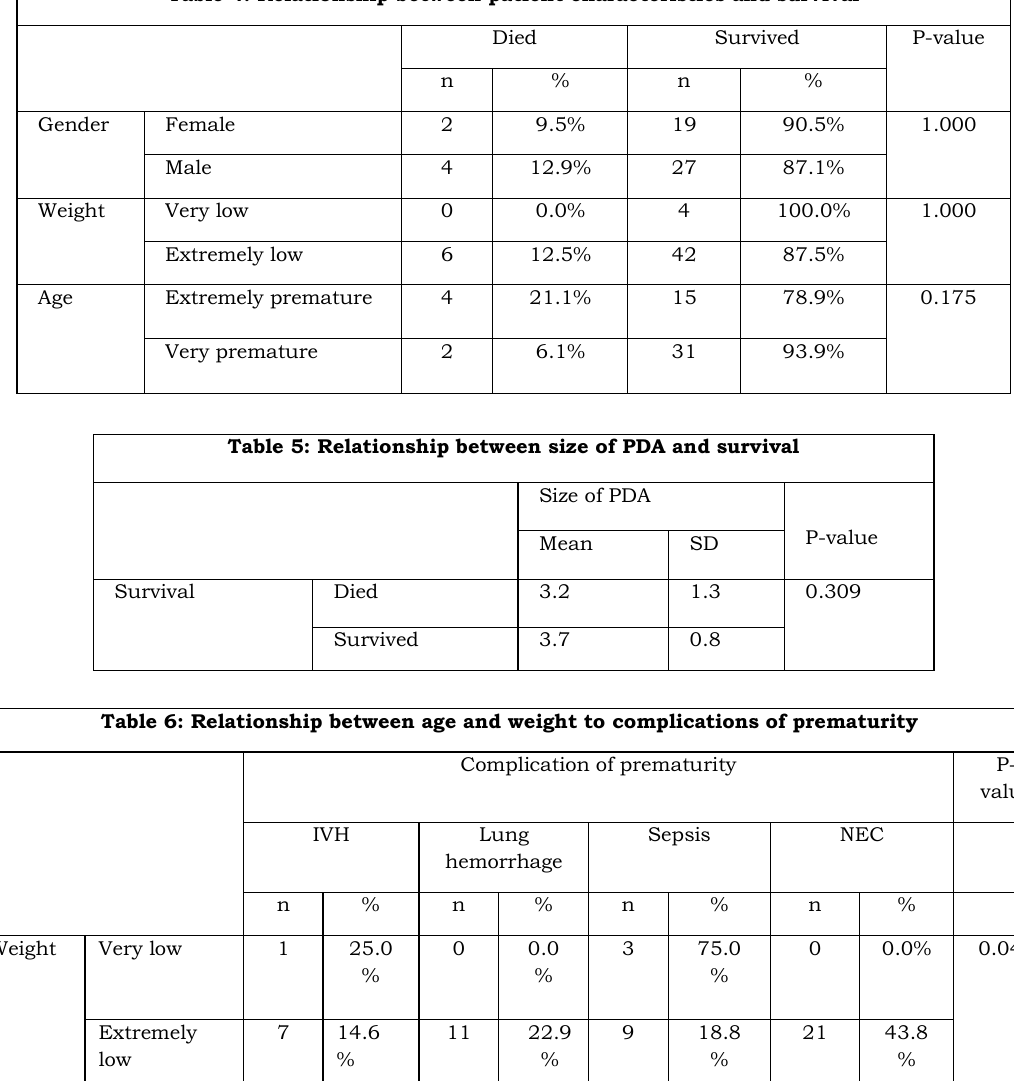
Table 4: Relationship between patient characteristics and survival